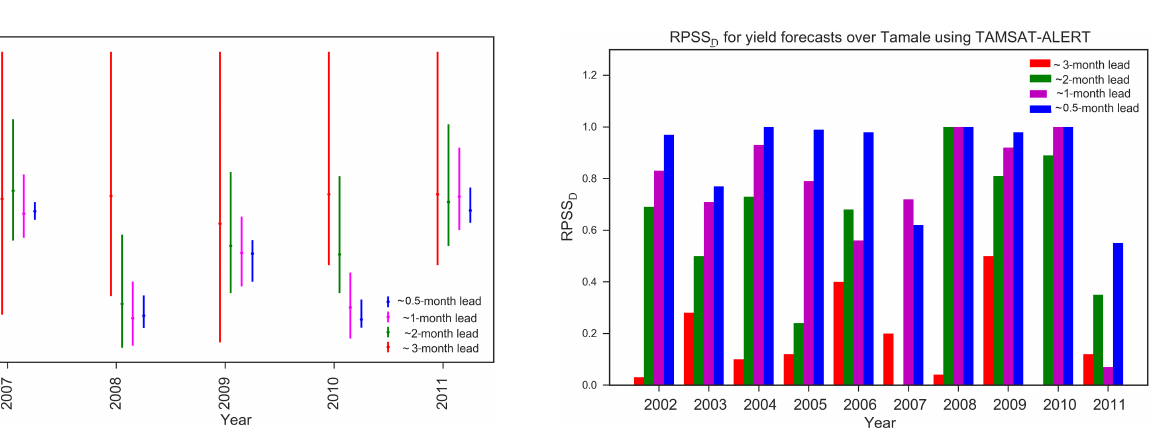
Figure 17. Time series of maize yield forecast in Ghana from 2007 to 2011 with four lead times of forecast. This is done using a hind- cast for each year and comparing the plots of ∼ 3-month lead time (red), ∼ 2-month lead time (green), ∼ 1-month lead time (magenta) and ∼ 0.5-month lead time (blue).